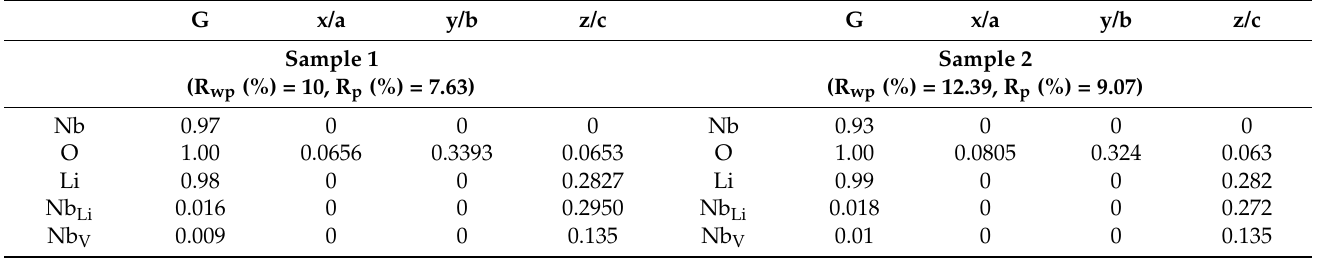
Table 4. Refined atoms coordinates (x/a, y/b, z/c) and population factors G in samples 1 and